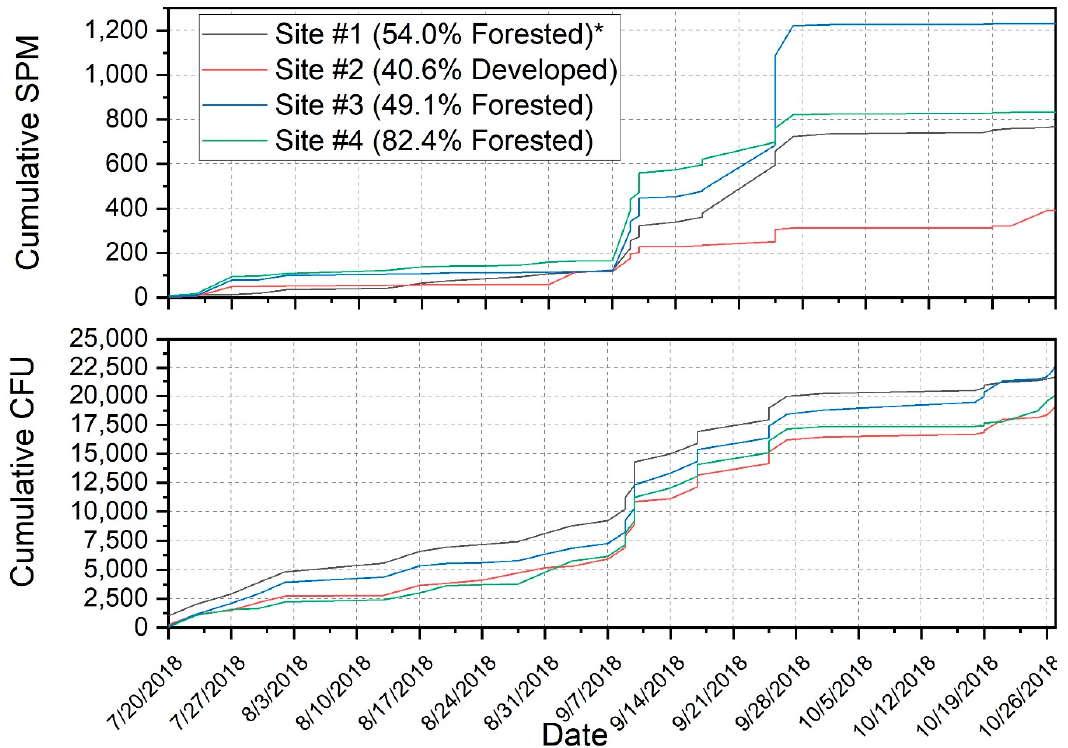
Figure 4. Top: cumulative total SPM (mg L − 1 ). Bottom: cumulative total E. coli concentration (CFU per 100 mL) at four monitoring sites during study period (20 July 2018–27 October 2018) in West Run Watershed, Morgantown, West Virginia, USA. * Only predominant land use percentage indicated, for full land use information refer to Table 1.